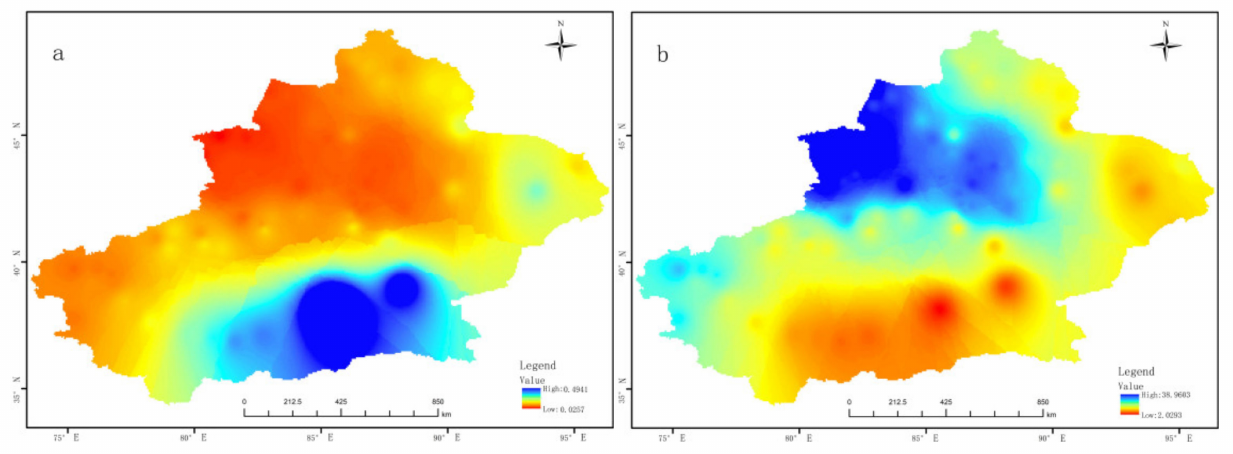
Figure 4. The station network of the Xinjiang regional 89 weather stations inhomogeneity measure- ment parameters distribution ( a ): Station domain area (unit: 20 × 10 4 km 2 /station); ( b ): Station network density (unit: station/20 × 10 4 km 2